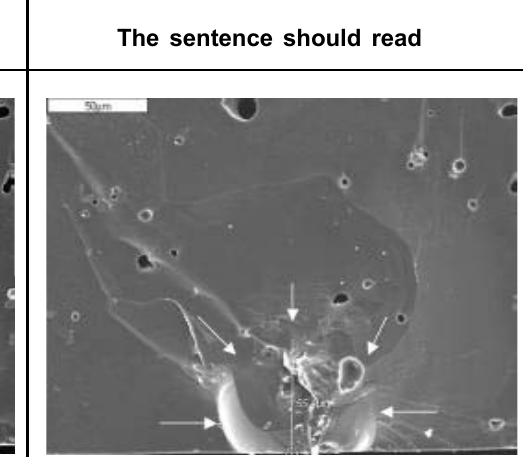
FIGURE 5 – SEM micrograph of ceramic fracture surface showing a critical flaw (crack) outlined by white arrows. Fracture surface of a amorphous glass (IPS Empress2 body, Ivoclar AG, Schaan, Liechtenstein; note the tailed fracture markings (top right) pointing toward the crack origin; measured line represents the semiminor axis a= 55µm (500x). From Della Bona, et al. 20 ,